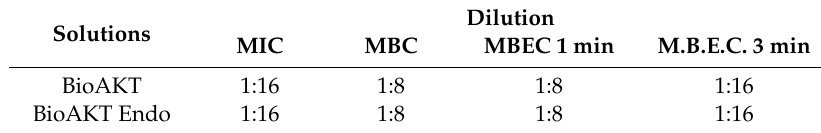
Table 4. Minimum inhibitory concentration (M.I.C.), minimum bactericidal concentration (M.B.C.), and minimum biofilm eradication concentrations (M.B.E.C.) of the tested solutions